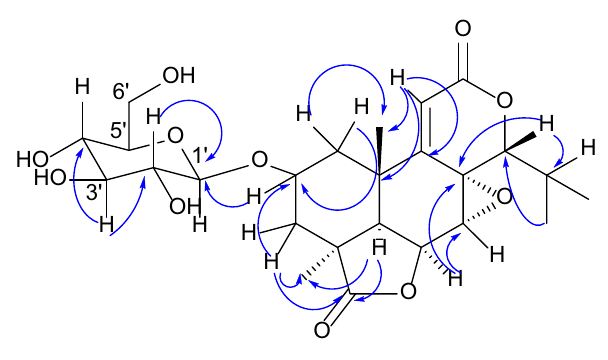
Fig. 3 Key HMBC correlations for